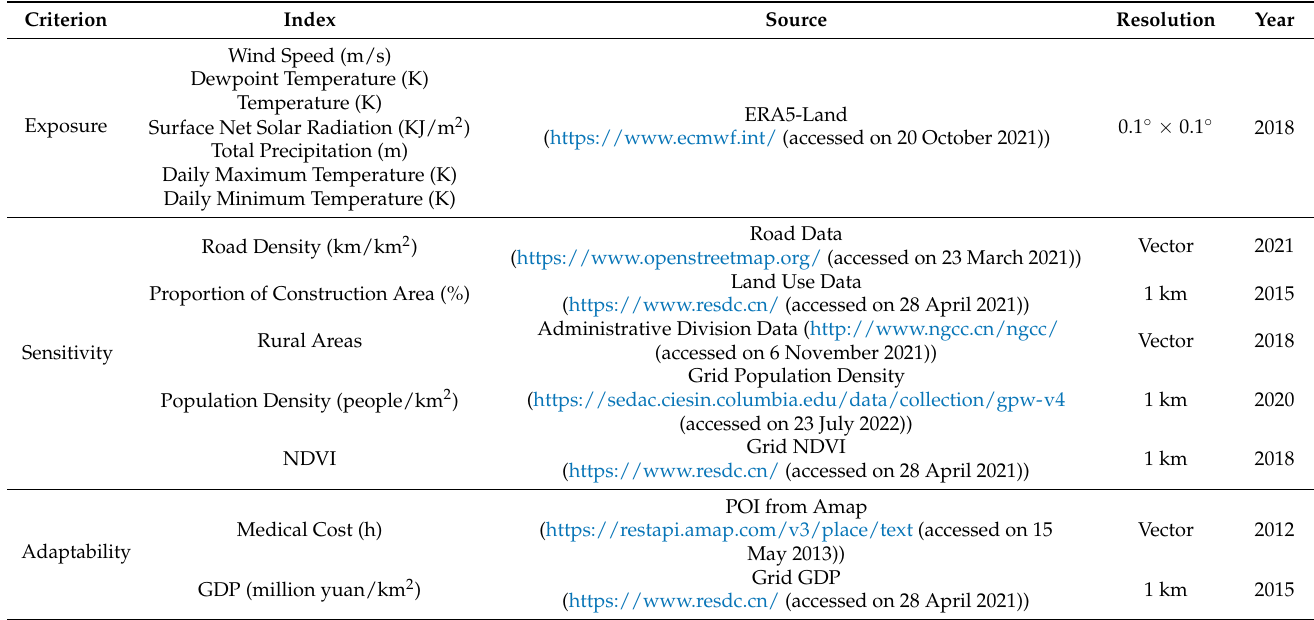
Table 1. Evaluation index system of foodborne diseases